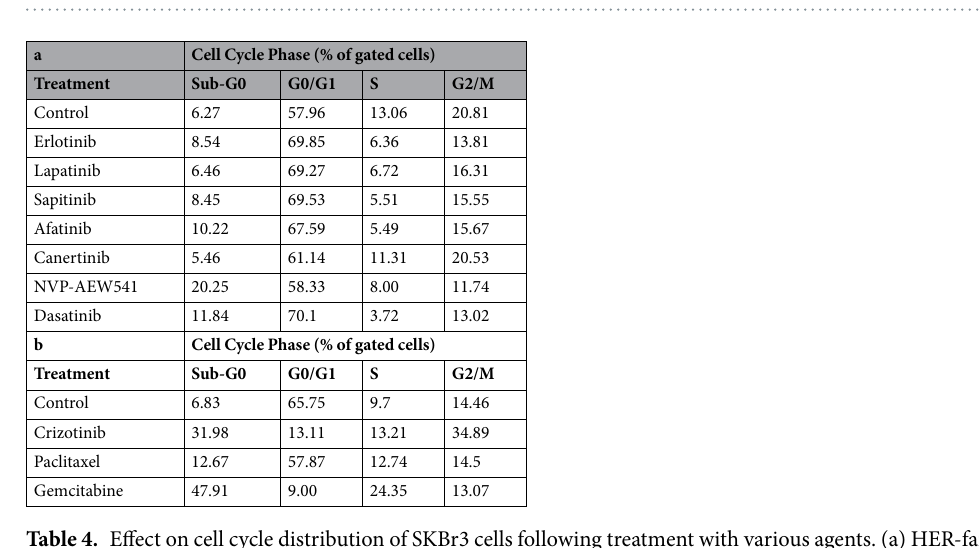
interrelated signalling pathways, and the dual and pan-HER inhibitors used in this study target both EGFR and HER-2, any effect of k-Ras mutations on EGFR sensitivity to these agents may have an effect on HER2 signalling. However, the direct effects of k-Ras mutation on HER2 in breast cancer are currently unclear, and warrant further investigation. As explained earlier, in some studies the aberrant expression and activation of other receptor tyrosine kinase and downstream cell signalling molecules (e.g. IGF-1R, c-Met, Src) have been shown to co-operate with HER family members to drive tumour growth and to confer resistance to therapy including treatment with HER inhib- itors 23–26, 31, 32 . The effects of a selection of agents targeting different tyrosine kinases and interfering with different stages of the cell cycle were therefore tested in combination on the growth of the HER2 overexpressing cell lines BT474, SKBr3 and MDA-MB-453, the EGFR overexpressing MDA-MB-468, and the low HER-family expressing MCF7. In our study, we found that the IGF-1R inhibitor NVP-AEW541 combined with HER-family inhibitors had mainly synergistic effects in MCF7 and MDA-MB-468. The synergistic effect of co-targeting of the EGFR and IGF-1R systems in MDA-MB-468 may be explained by high and moderate levels of expression of EGFR and IGF-1R respectively (Table 1). MCF7 cells had the highest level of IGF-1R expression but had relatively low expression of HER-family members. In another recent study, Chakraborty et al . 72 have reported that treatment of MCF-7 cells with a combination of an IGF-1R mAb and the HER2 targeting agents neratinib and trastuzumab